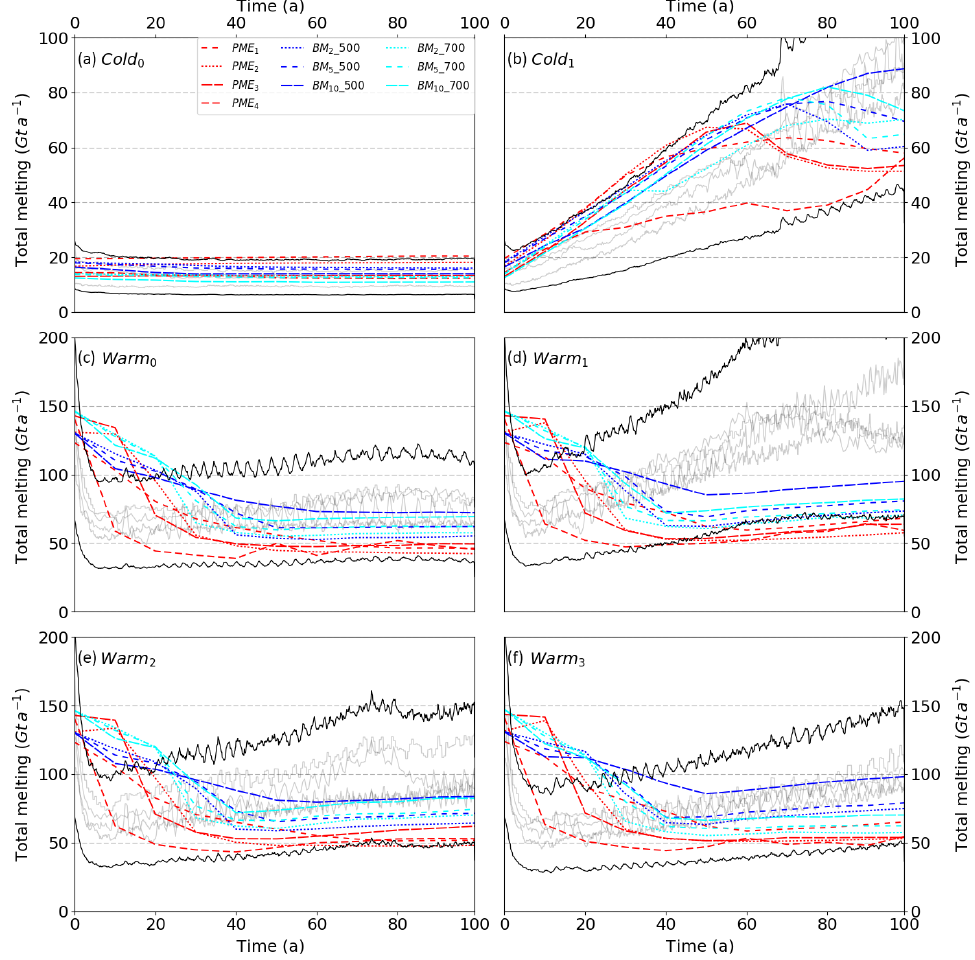
Figure 6. Similar to Fig. 5 but for more complex parameterisations (Sect.